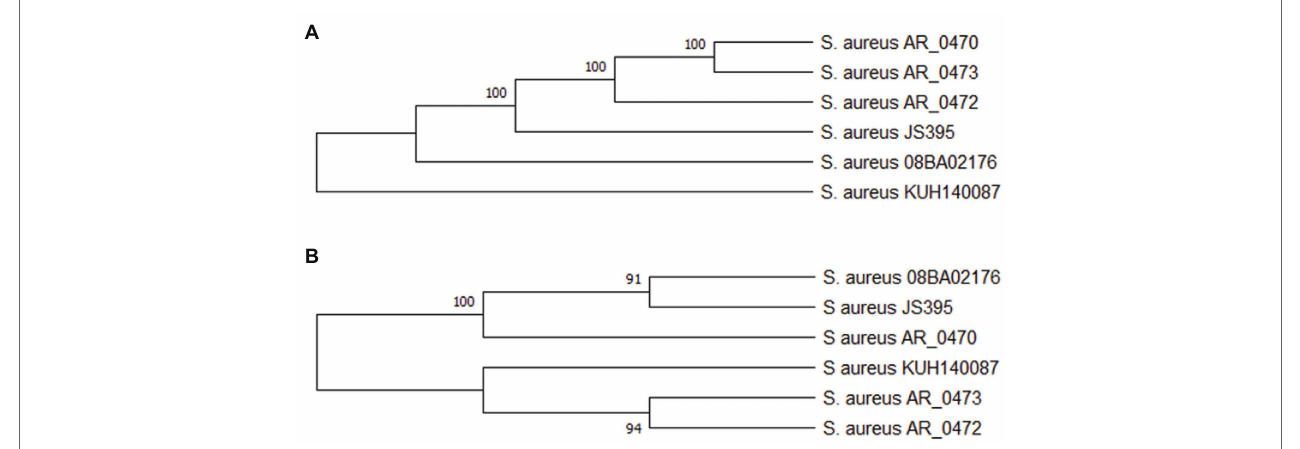
FIGURE 2 | Protein Cas phylogenetic relation (A) and SRc (B) . The alignment of the amino acid sequences of the proteins Cas and SRc was done with ClustalO, and the phylogenetic trees of SRc and the Cas proteins were built with the neighbor-joining and UPGMA method. There is a tree for the protein Cas (Cas1, Cas2, Cas10/Csm1, and Cas6) because they presented the same phylogenetic relation. The trees are the consensus of 1,000 bootstrap, and they were done with MEGA